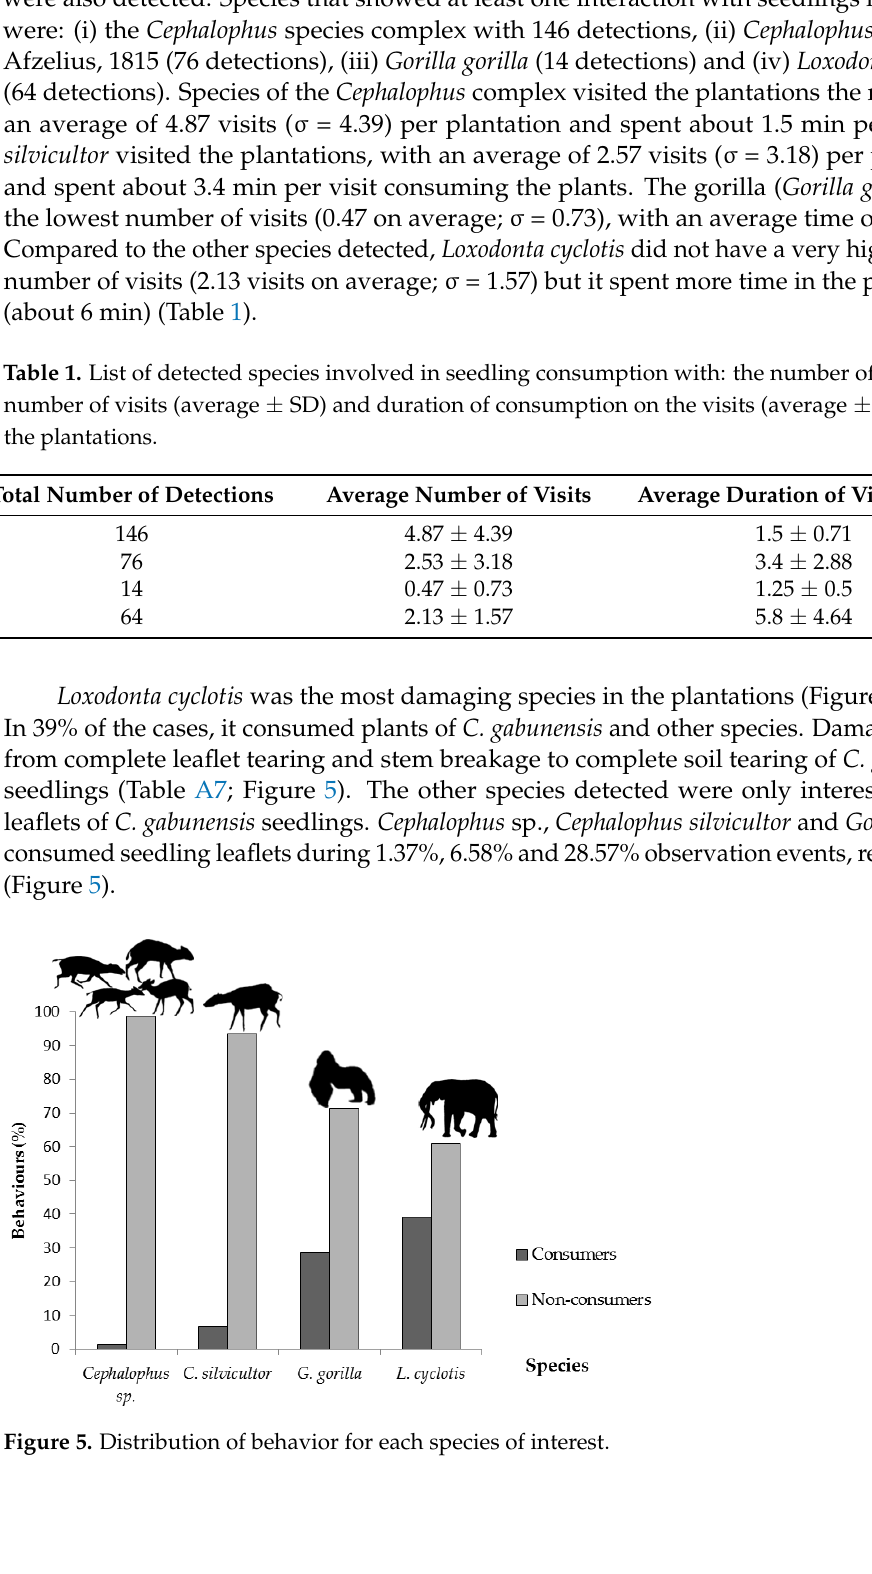
Figure 6. Consumers of C. gabunensis seedlings in plantations; ( a – e ): L. cyclotis ; ( f ): G. gorilla .